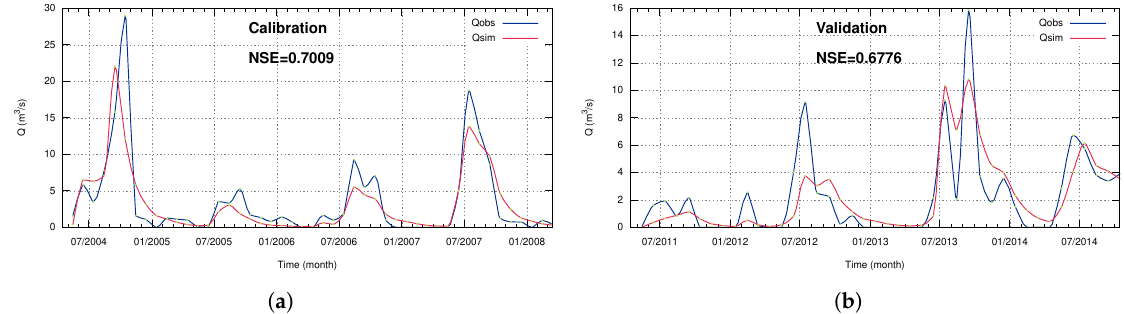
Figure 4. Efficiencies of hydrological modeling in ( a ) the calibration period and ( b ) the validation ( − Qobs = measure discharge and • Qsim = simulated discharge).